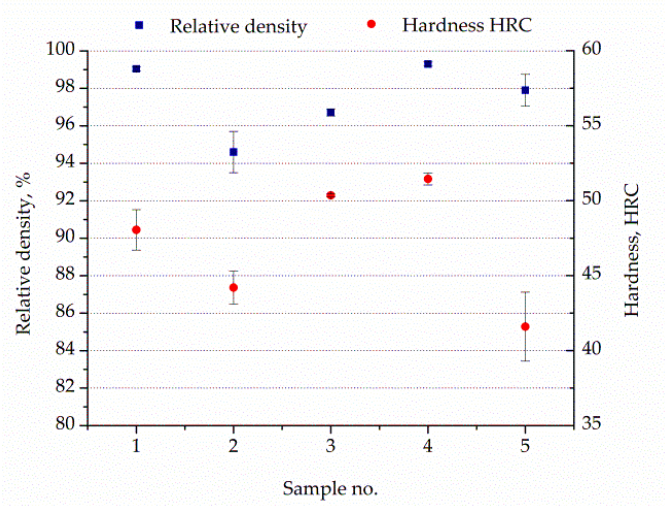
Figure 4. Relative density and hardness of the analyzed components after aging